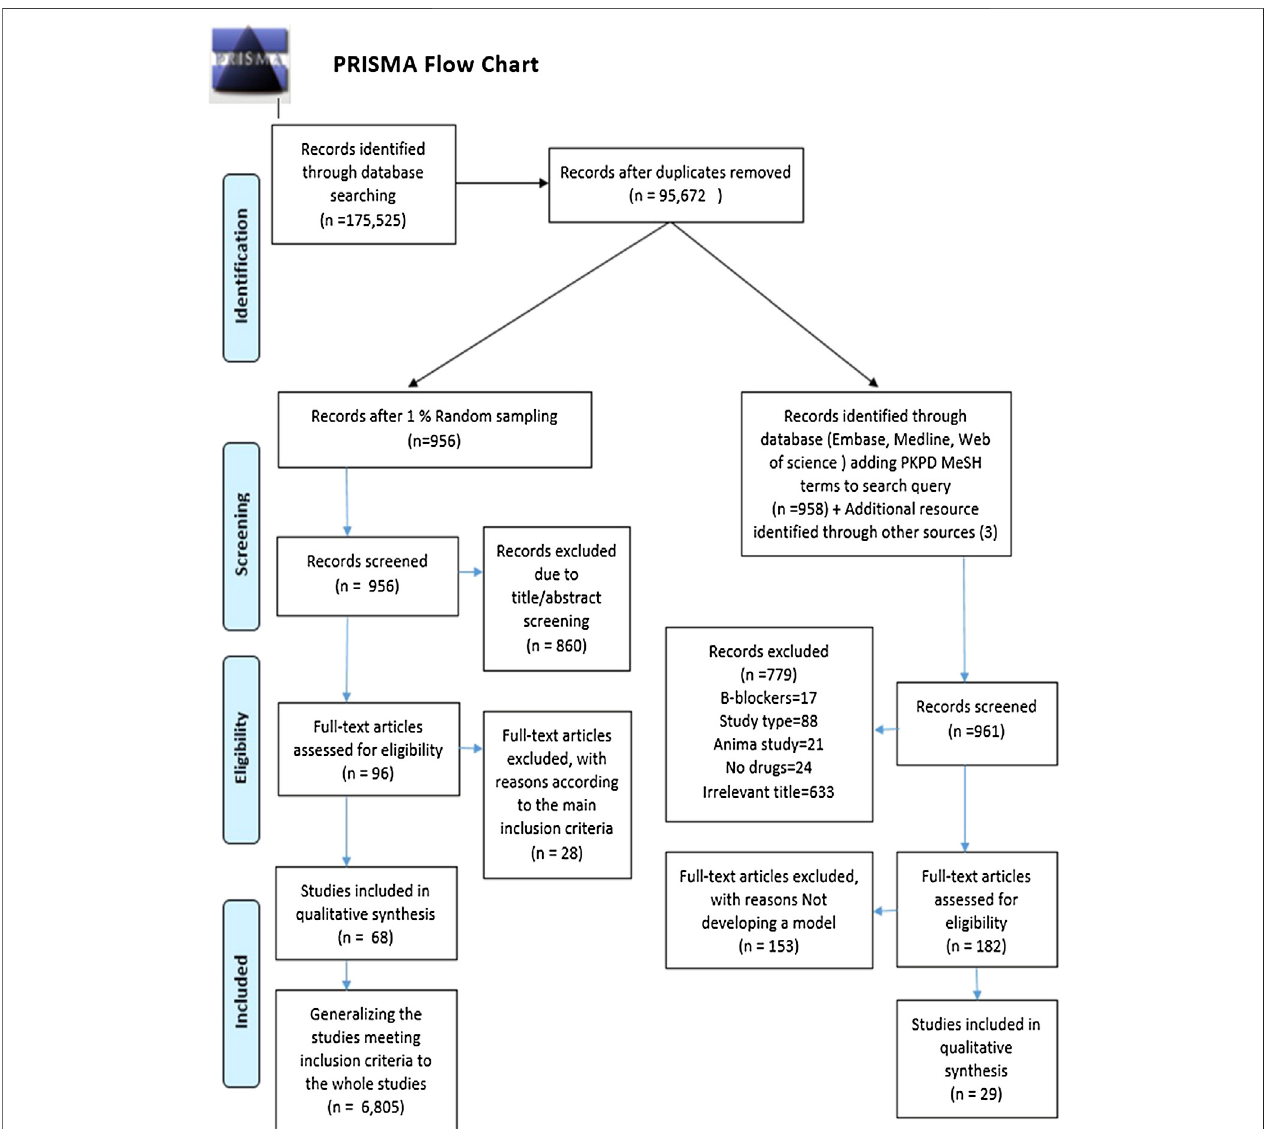
FIGURE 1 | PRISMA fl ow